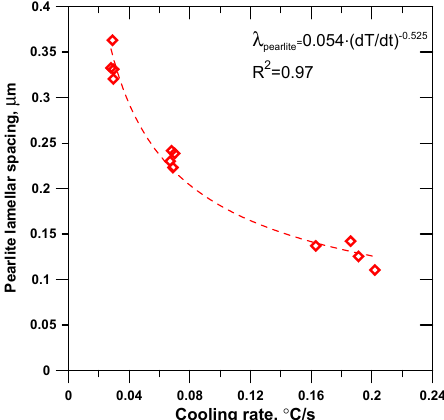
Figure 1 should be replaced by the following figure: